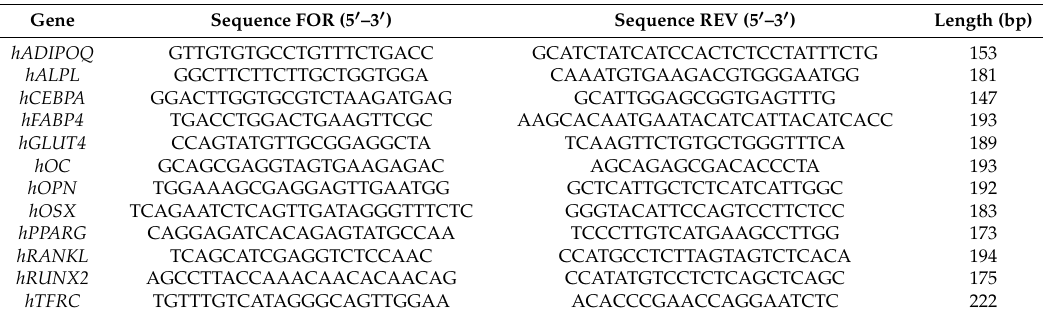
Table 4. Human primer